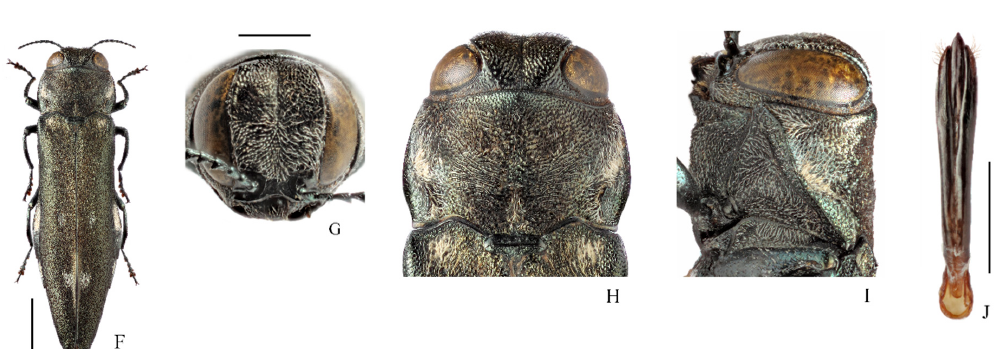
Figure 3. ( A – E )— Agrilus fleischeri Obenberger, 1925, ( A – D )—female, ( E )—male. ( A )—Habitus;